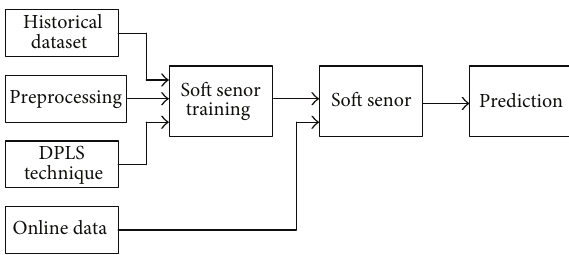
Figure 6: Flow diagram of the proposed soft sensor.